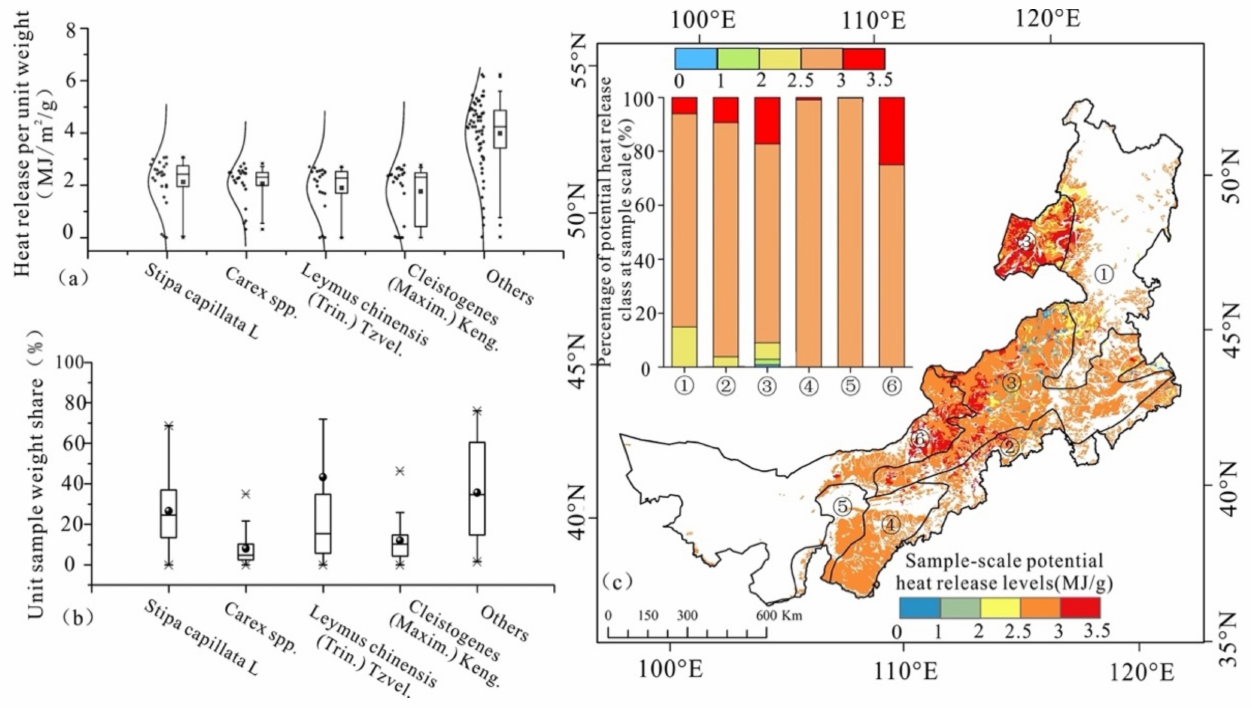
Figure 8. Statistical maps of experimental heat release ( a ), plant share ( b ), and spatial distribution of potential heat release ( c ) (Note: 1 (cid:13) – 6 (cid:13) see Figure